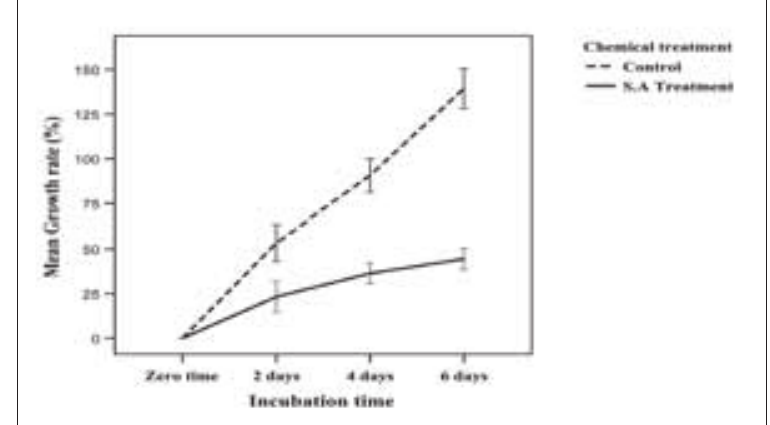
Figure 1. Effect of salicylic acid on mycelial growth of Monilinia laxa in vitro . Data are expressed as the mean of triplicate assays. Vertical bars represent the standard errors of